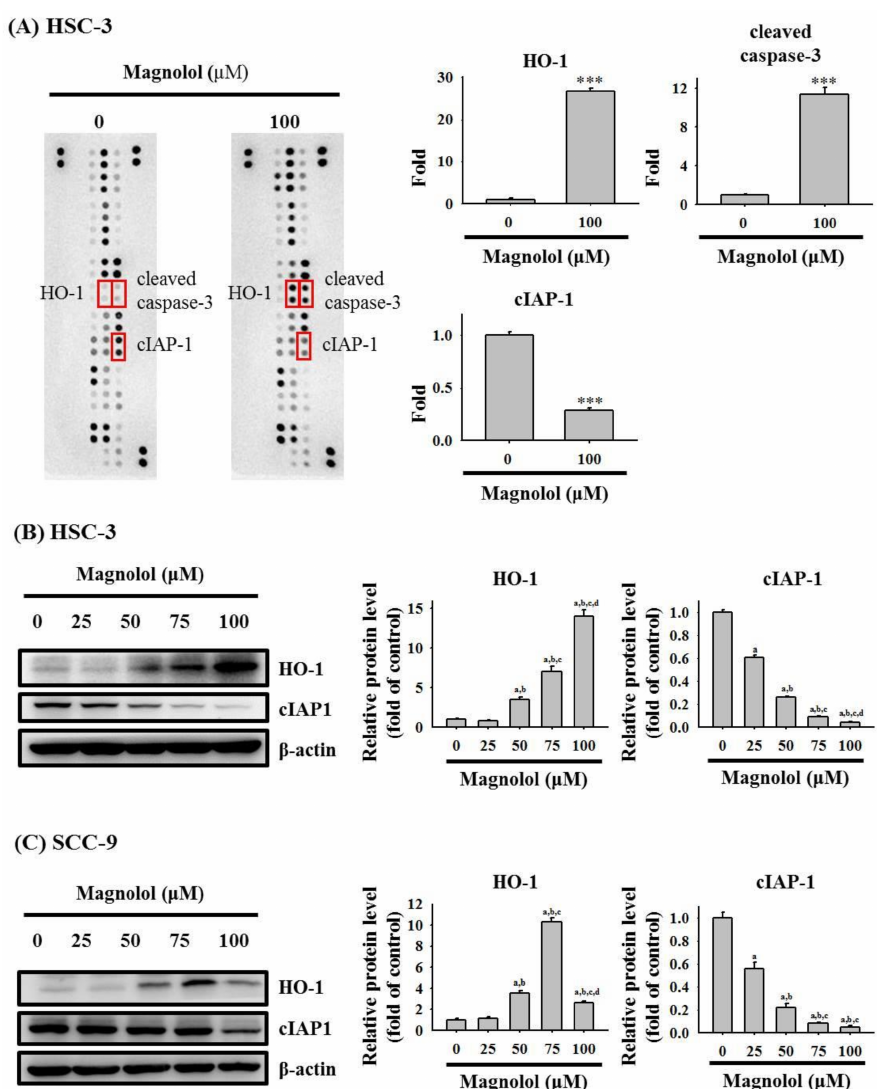
Figure 4. Screening of apoptosis-related proteins modulated by magnolol in oral cancer HSC-3 cells. ( A ) Whole cell lysate from HSC-3 cells was treated with or without magnolol (100 µ M) for 24 h via apoptotic protein array analysis. *** p < 0.005, compared with control group. ( B , C ) Protein levels of HO-1 and cIAP-1 proteins in the ( B ) HSC-3 cells and ( C ) SCC-9 cells were measured through Western blot assay. The data represent the mean ± SD of three independent experiments. a Significantly different, p < 0.05, when compared to control. b Significantly different, p < 0.05, when compared to 25 µ M. c Significantly different, p < 0.05, when compared to 50 µ M. d Significantly different, p < 0.05, when compared to 75 µ